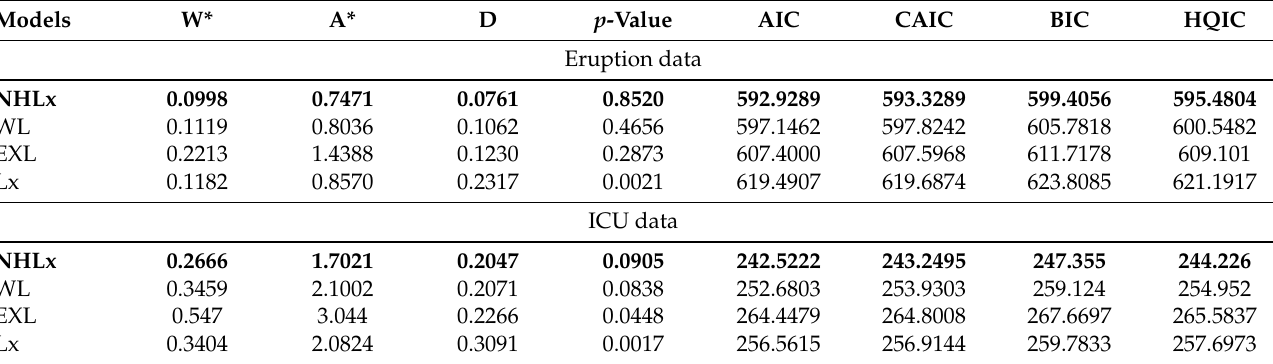
Table 5. Values of the statistical measures for the considered